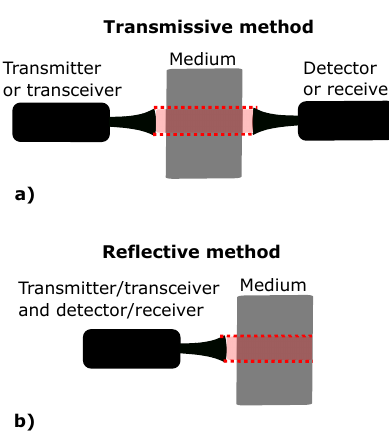
Figure 2. ( a ) Illustration of transmissive method. ( b ) Illustration of reflective